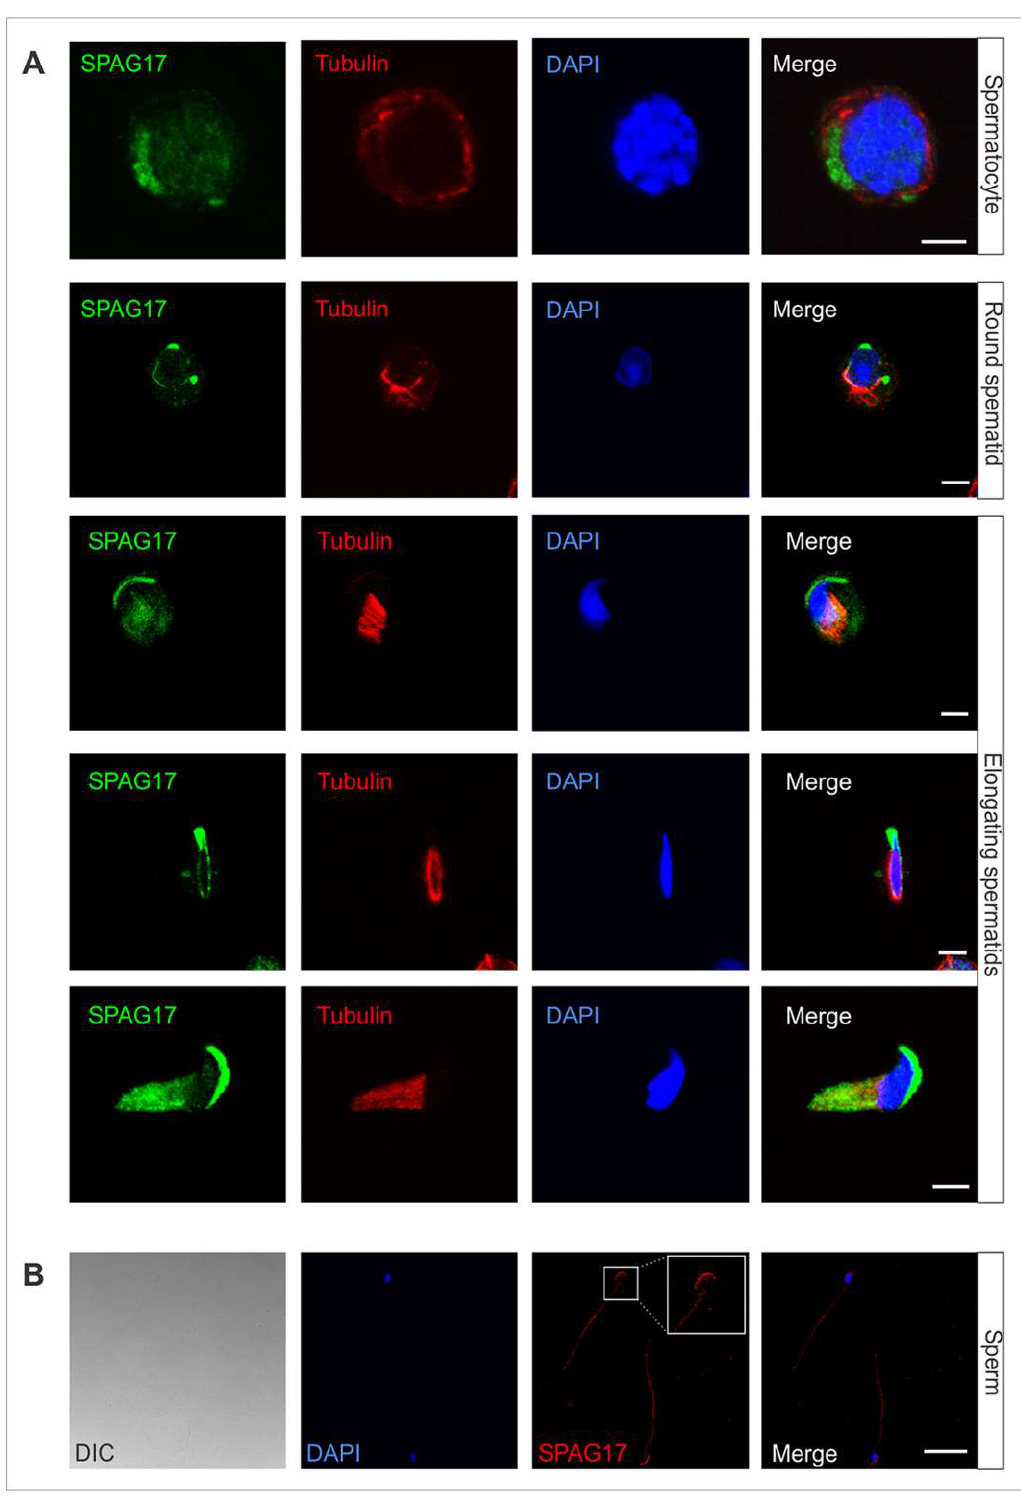
Figure 1. Distribution of SPAG17 in germ cells. Immunofluorescence was performed on ( A ) mixed germ cells collected from wild-type mice. Acetylated α -tubulin was used as a marker for microtubules. The images show SPAG17 in the cytoplasm of spermatocytes and round spermatids and co-localization with manchette microtubules in elongating spermatids. Scale bars = 5 µ m. ( B ) In sperm, SPAG17 decorates the acrosome and the tail. DIC, Differential interference contrast. Scale bar = 25 µ